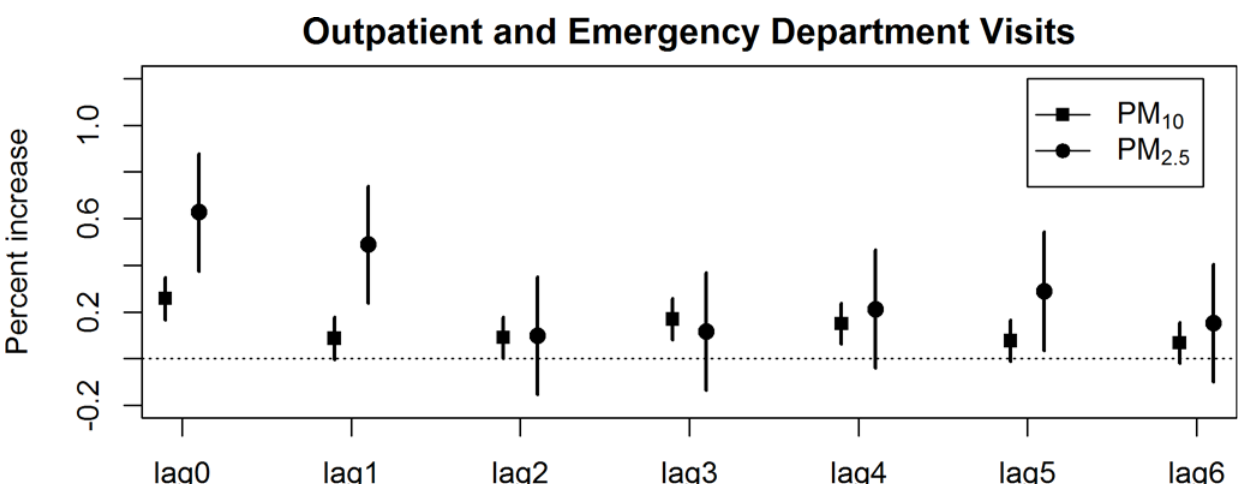
Fig 2. Estimated percent difference in CHD outpatient and emergency department visits (95% CI) in association with a 10 μ g/m 3 increase in PM 10 and PM 2.5 by lag days.